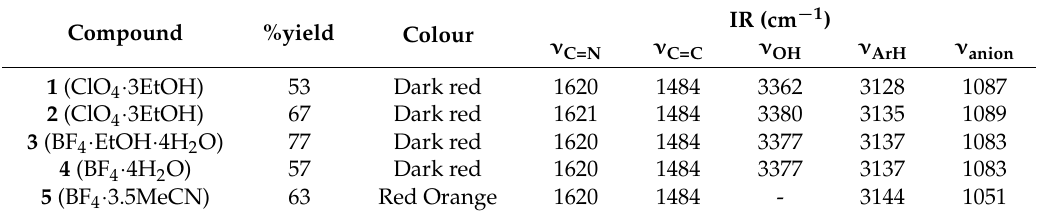
Table 2. Physical and IR spectroscopic data for fac -[Fe(4-ima-Bp) 3 ](Y) 2 · sol. Compound